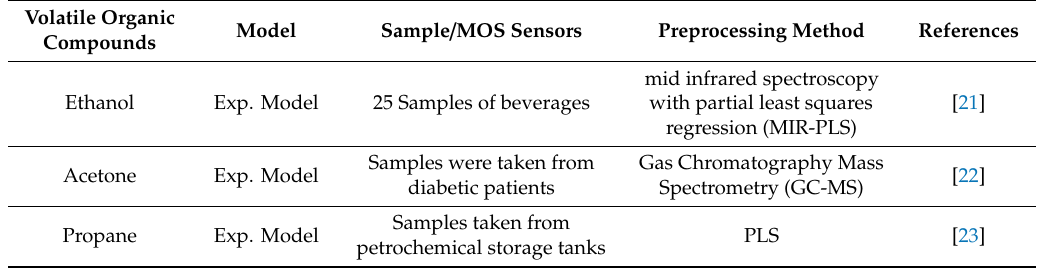
Table 2. Comparison with other published work.